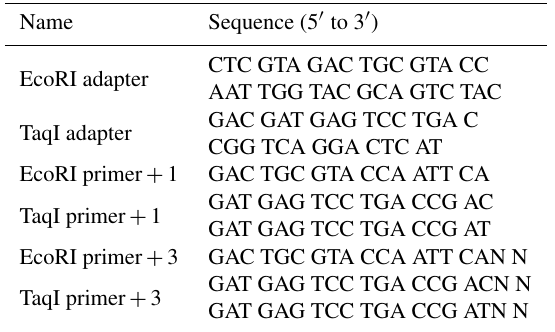
Table 1. Sequence of AFLP adapters and primers. Name Sequence (5 (cid:48) to 3 (cid:48)